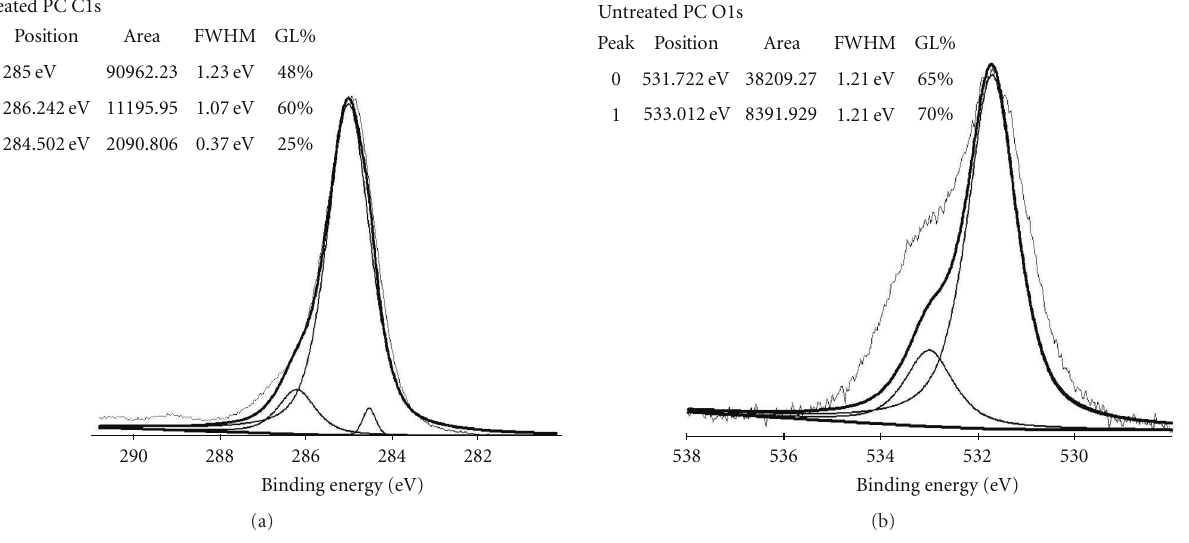
Figure 9: XPS spectra of (a) C1s peak (b) O1s peak of untreated PC film.